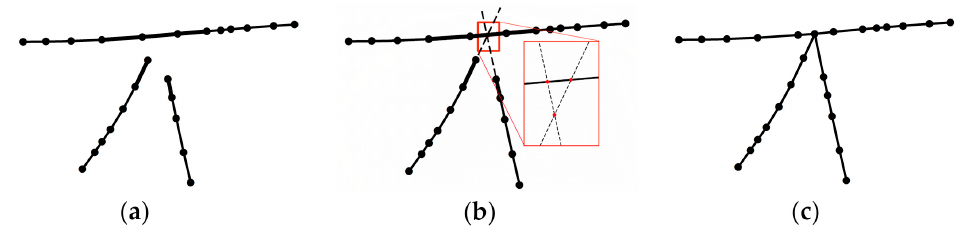
Figure 6. Detecting the location of the intersection based on the intersect of segments with conflicting orientations. ( a ) Identifying the conflicting road segments around the intersection from the previous steps; ( b ) road segments intersecting at multiple points; and ( c ) calculating the intersection location based on multiple points.